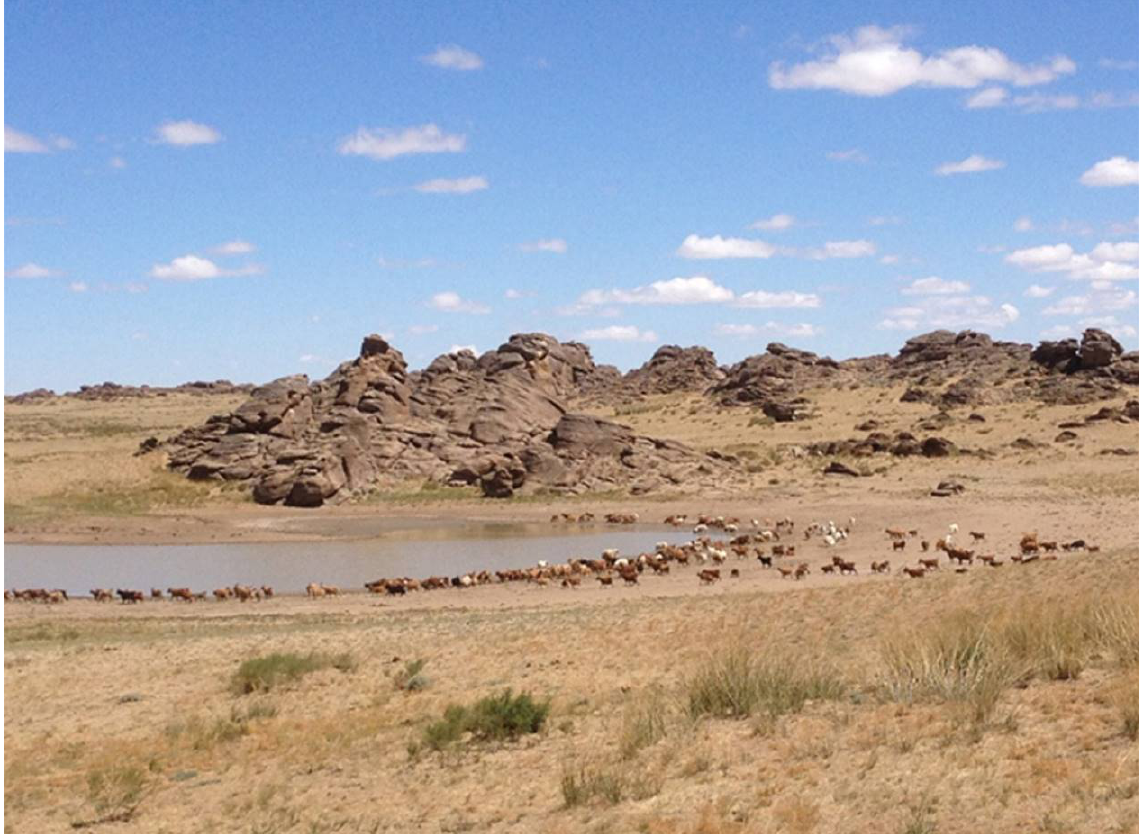
Figure 5. Water fills small lake playas during periods of precipitation in Ikh Nart. This provides temporary water source for mixed goat and sheep